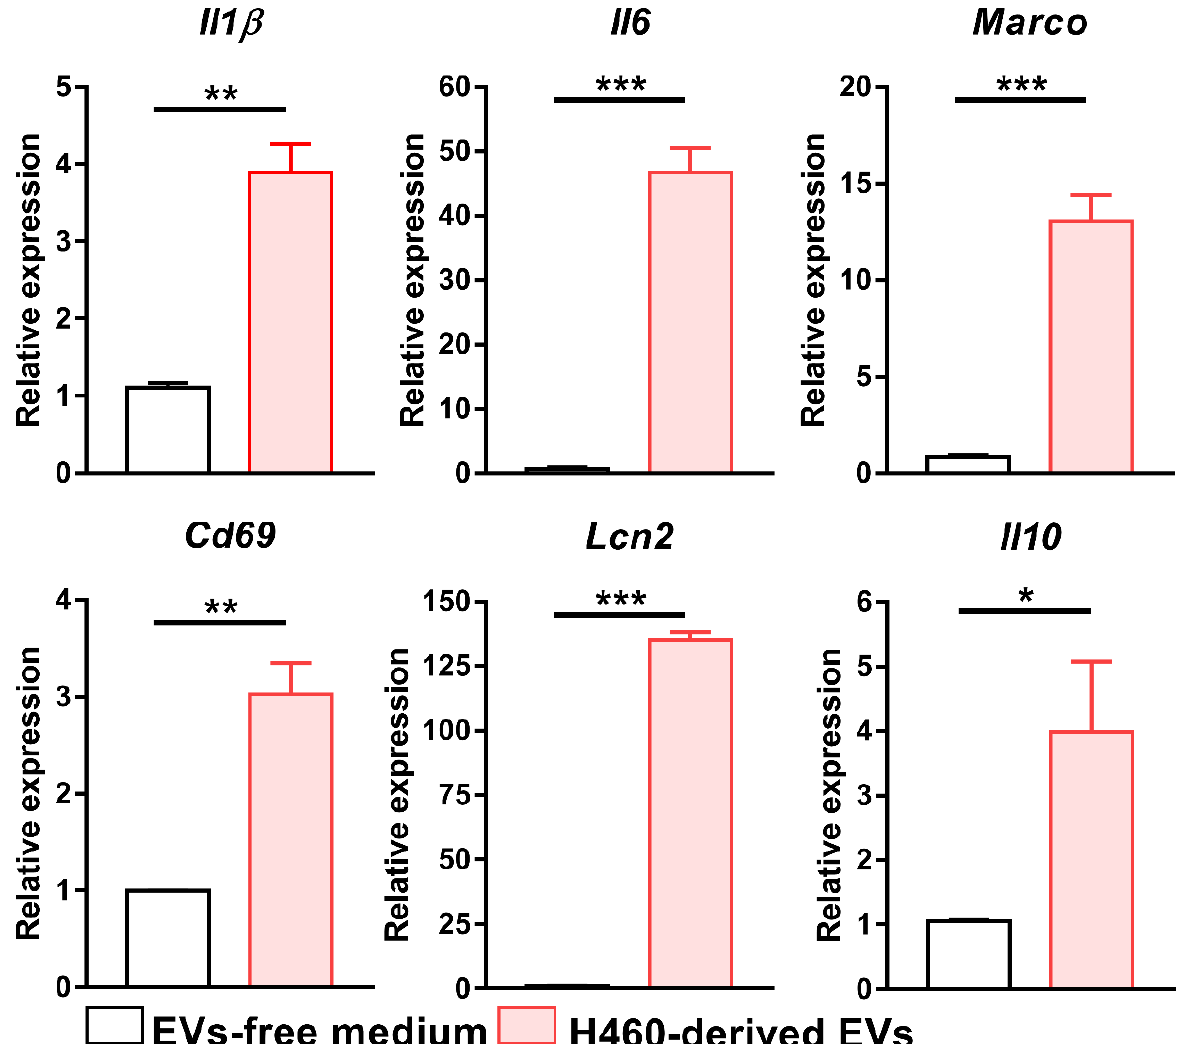
Figure 8. Effect of H460 EVs on BMDMs. mRNA level of Il1 β , Il6 , Marco , Cd69 , Lcn2 and Il10 genes, as determined by Real-Time PCR after BMDM exposure to H460-derived EVs, isolated by ultracentrifugation. Data were normalized to the housekeeping gene expression level ( β 2m ) and analyzed by the comparative 2 − ΔΔ Ct method. Data are presented as the mean ± SEM. * p < 0.05, ** p < 0.01, *** p < 0.001 by unpaired t -test.